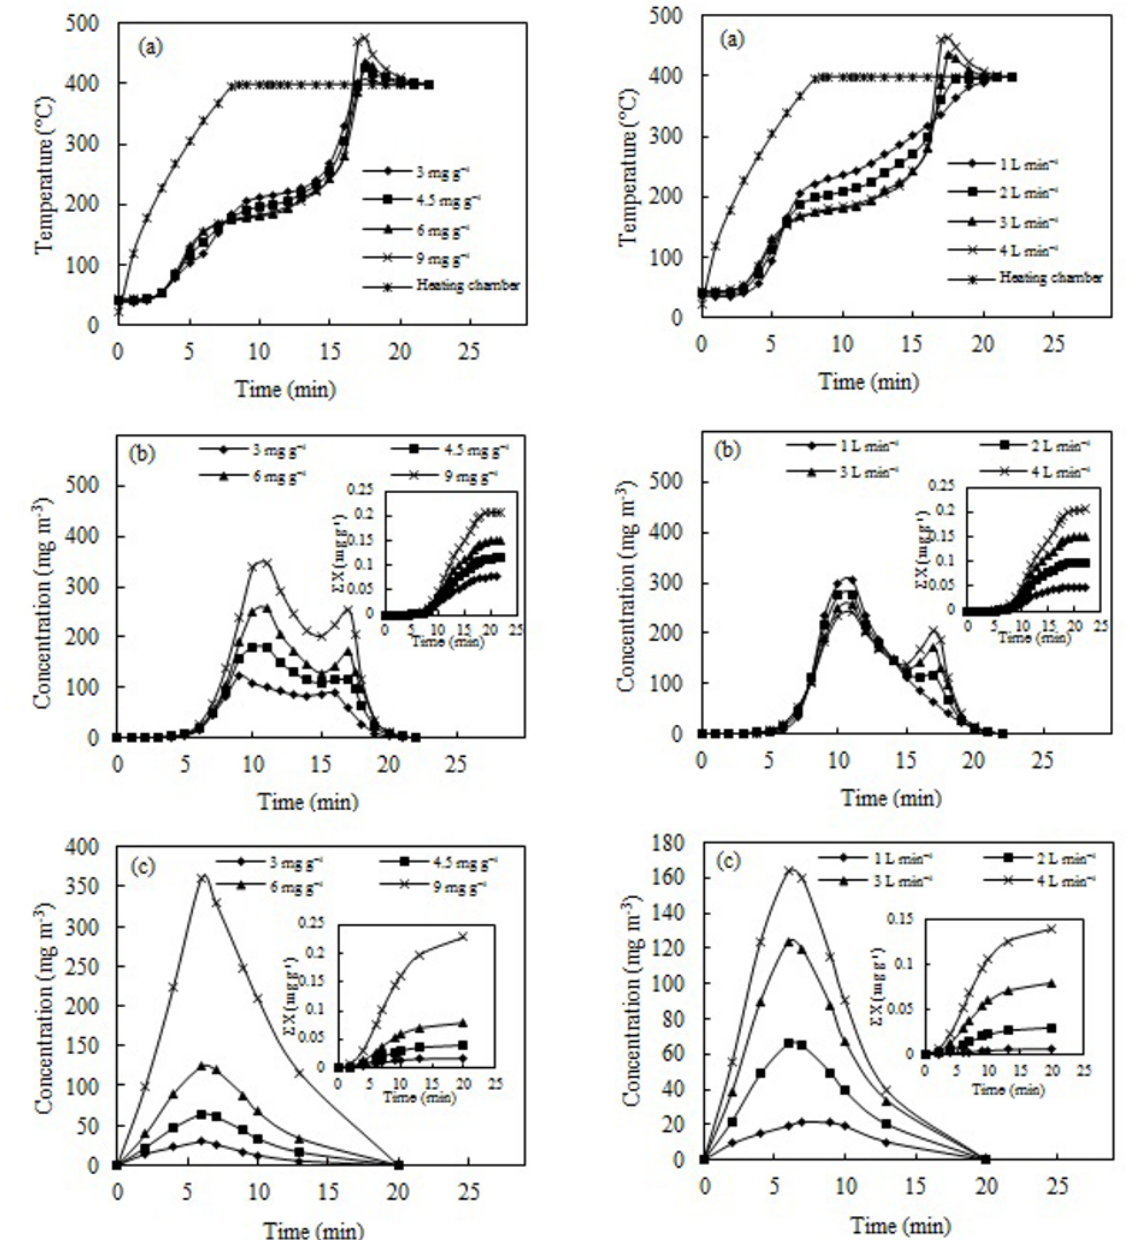
Figure 4. Temperature swing oxidation of o-xylene at different adsorbent-catalyst saturation levels: (a) temperature profiles of reactor and heating chamber; (b) evolution of CO; (c) thermal runaway of toluene; insets - integral amounts ( Σ X) of desorbed/formed component.